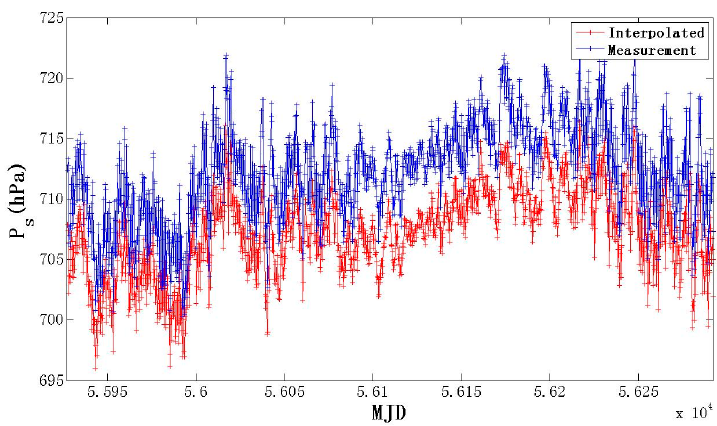
Figure 5. Interpolated and measured surface pressure time series at ISD station 564620.